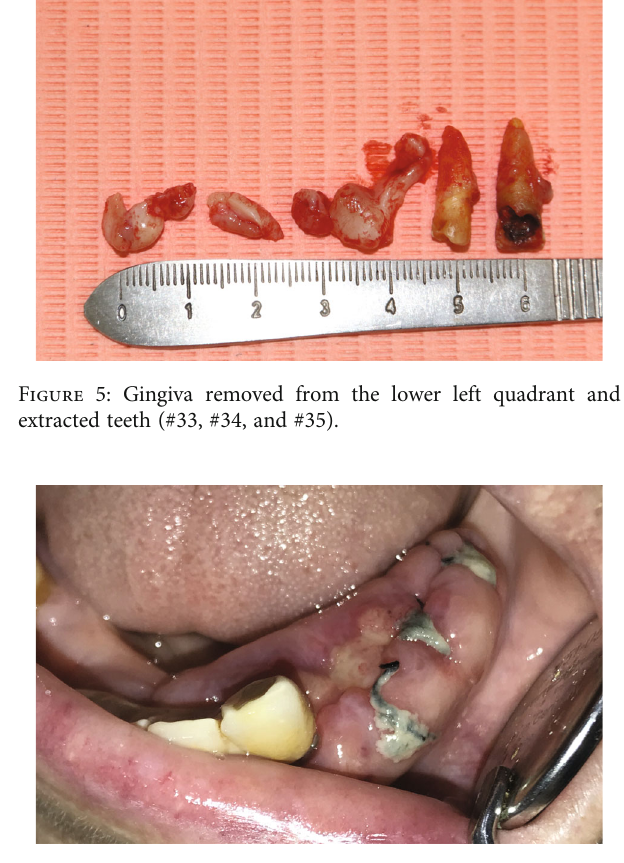
Figure 6: 1 week after surgical excision of the lower left quadrant.